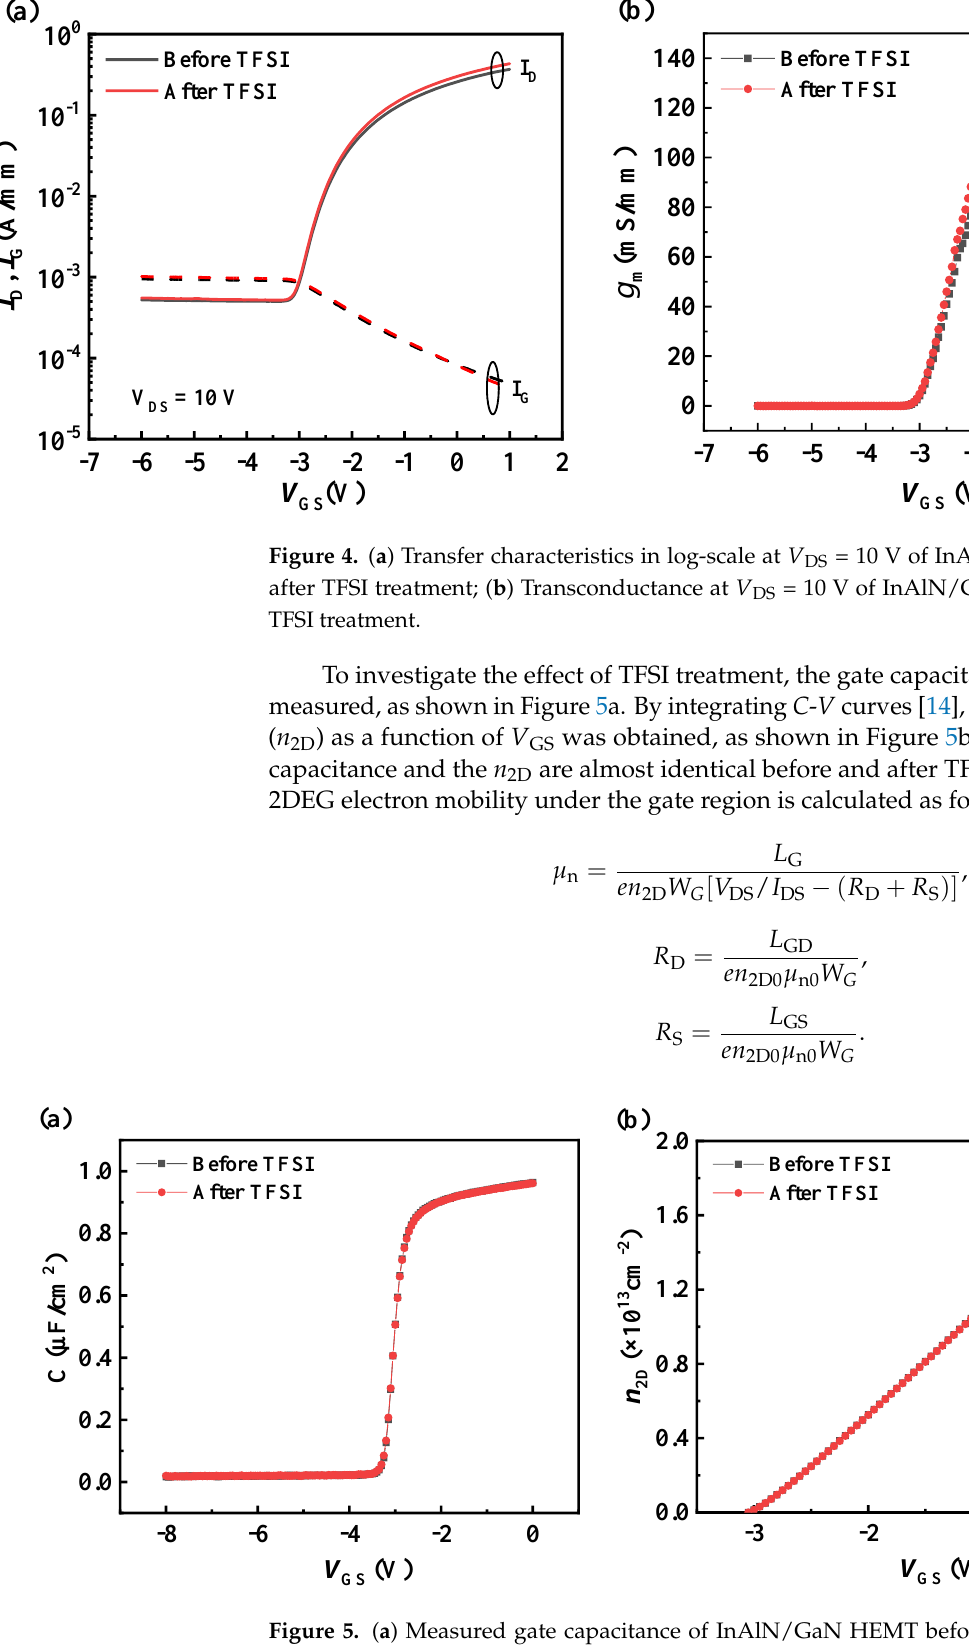
Figure 3. ( a ) I - V output characteristics of InAlN/GaN HEMT before and after TFSI treatment; ( b ) Transfer characteristics at V DS = 10 V of InAlN/GaN HEMT before and after TFSI treatment.